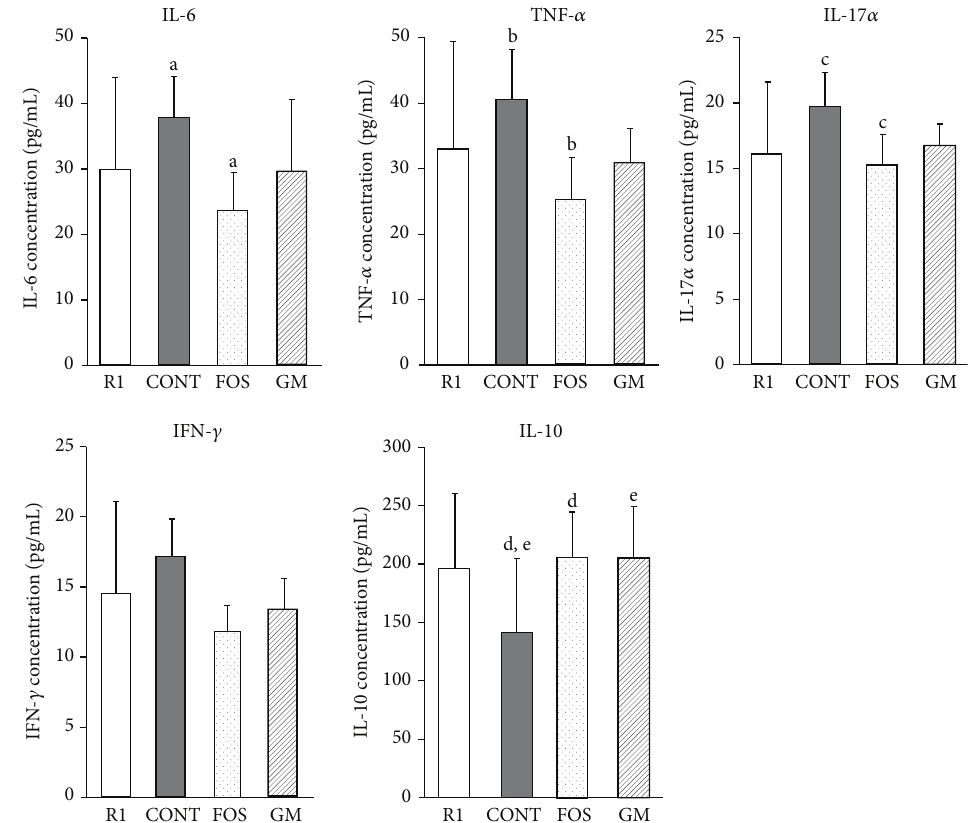
Figure 7: Difference in serum inflammatory cytokines at 38 weeks after feeding. Values were expressed as mean ± SD. R1, SAMR1, and control diet, 𝑛 = 5 ; CONT, control diet, 𝑛 = 7 ; FOS, 5% of fructooligosaccharide diet, 𝑛 = 8 ; GM, 5% of glucomannan diet, 𝑛 = 9 . a–e: significant differences were evaluated by ANOVA and same superscripts were significantly different by Tukey’s post hoc test, at 𝑃 < 0.05